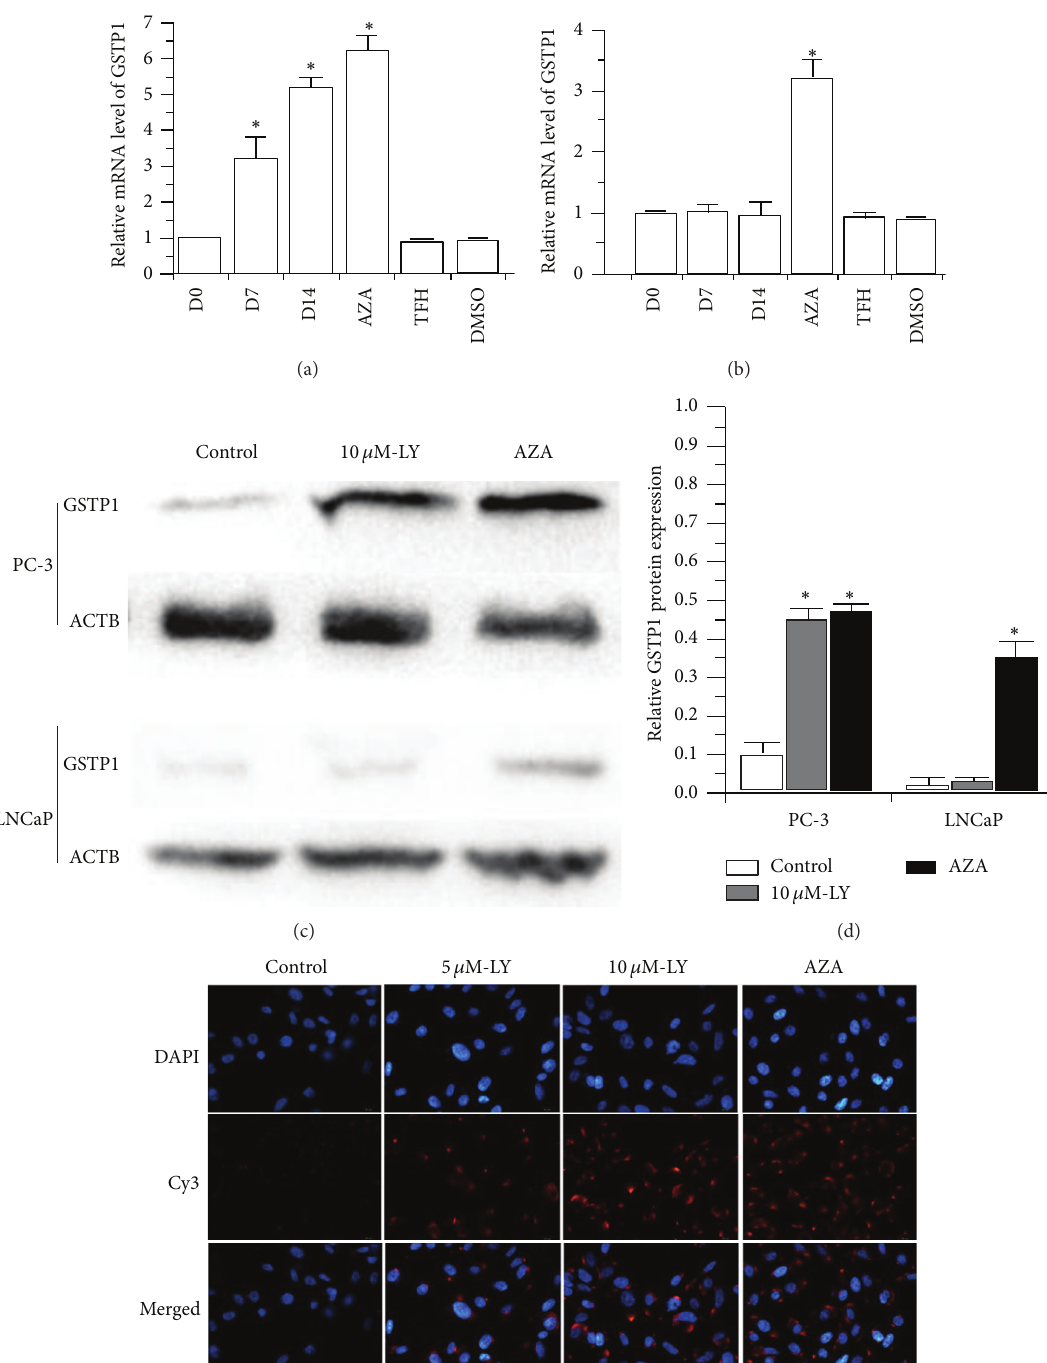
Figure 2: Lycopene induced expression of GSTP1 in PCa cell lines. qPCR detection of the relative mRNA level of GSTP1 in PC-3 (a) and LNCaP (b) cells with 10 𝜇 M of lycopene at 0 days (D0), 7 days (D7), and 14 days (D14) and treated with the DNMT inhibitor AZA and vehicles DMSO and TFH. Western blot analysis of GSTP1 protein in PC-3 (c) and LNCaP (d) cells with different treatments. (e) Immunofluorescence detection of GSTP1 protein expression in PC-3 cells treated by lycopene and AZA. LY,